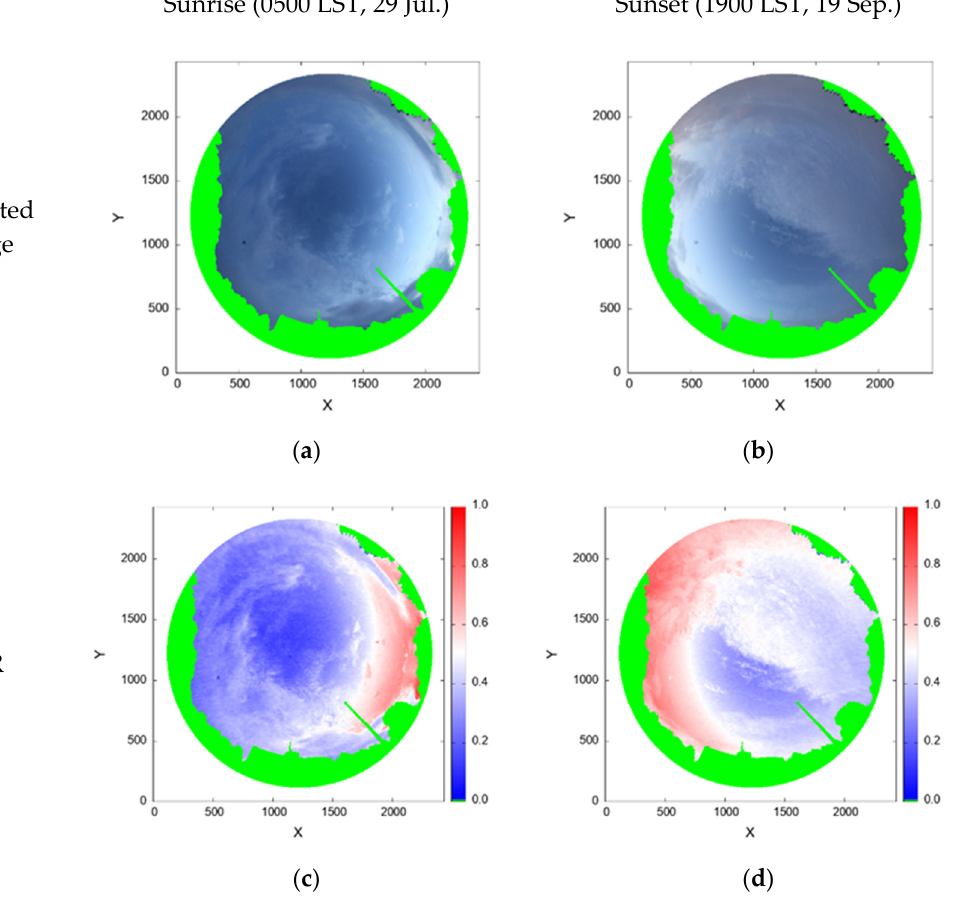
Figure 7. Distortion correction and RBR distribution images of the sunrise ( a , c ) and sunset ( b , d ) cases. For the sunrise case, the human observation cloud cover of DROM was 6 tenths while the cloud cover of ACOS was calculated to be 0 tenths. For the sunset case, the human observation cloud cover of DROM was 9 tenths while the cloud cover of ACOS was calculated to be 0 tenths. Remote Sens. 2020 , 12 , x FOR PEER REVIEW